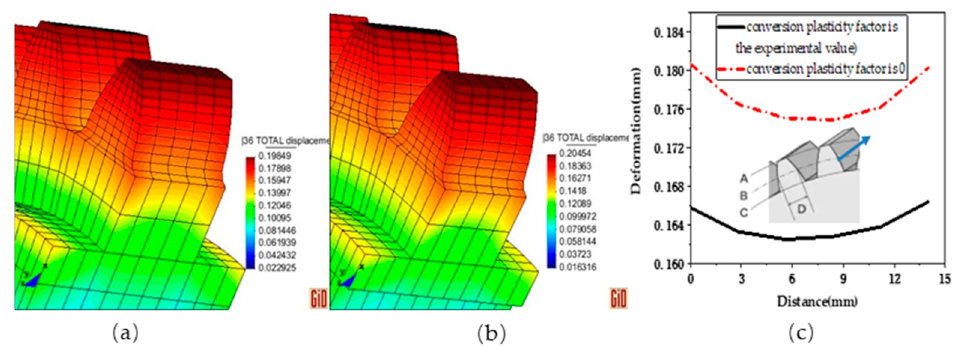
Figure 12. Distortion results of 20MnCr5 steel gears after carburizing and quenching. ( a ) The 3D distortion results with considered transformation plasticity; ( b ) the 3D distortion results without transformation plasticity; ( c ) distortion results at the gear knuckle after carburizing and quenching.